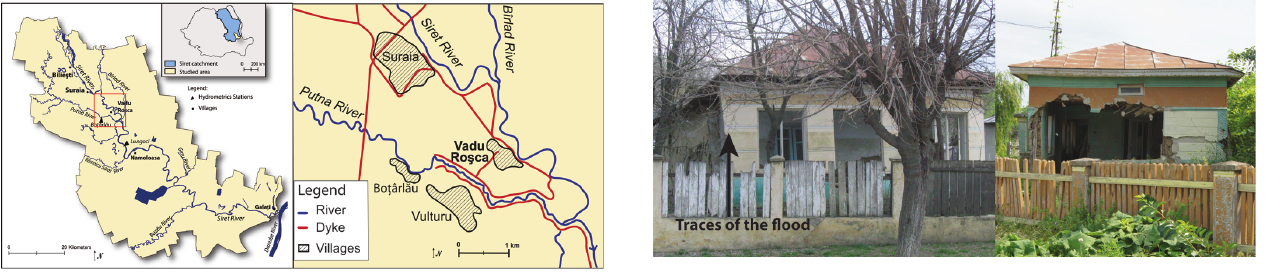
Fig. 1. Localisation of the lower Siret River and of the village of Vadu Ros¸ca.